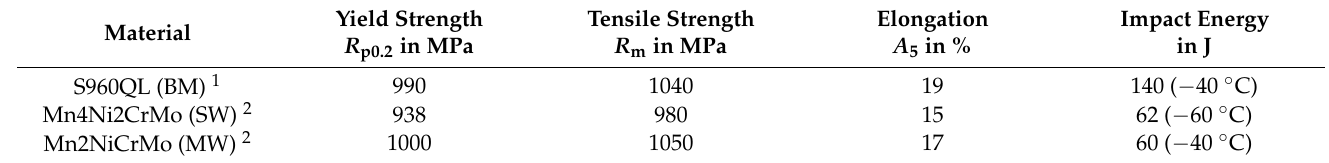
Table 2. Mechanical properties of test materials.